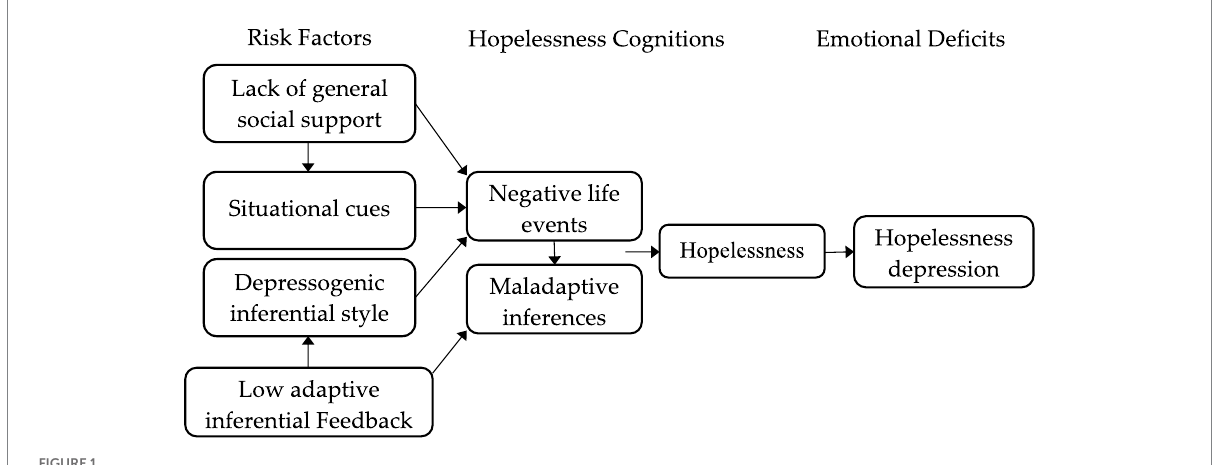
FIGURE 1 The expanded hopelessness theory of depression (based on Panzarella et al.,